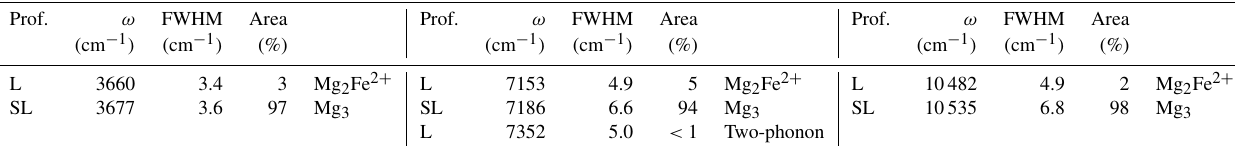
Table 1. Profile function (prof.), frequency ( ω ), full width at half maximum (FWHM) and relative area of bands related to structural OH groups in the MIR and NIR spectra of talc. Proposed assignments are also indicated in terms of cationic environments or contribution to the two-phonon continuum (two-phonon).